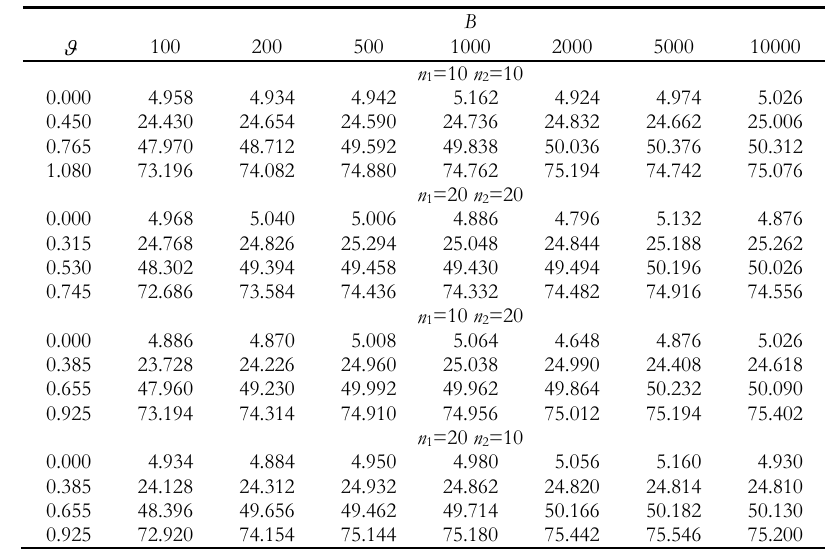
Percent power estimates of T for (cid:68) =